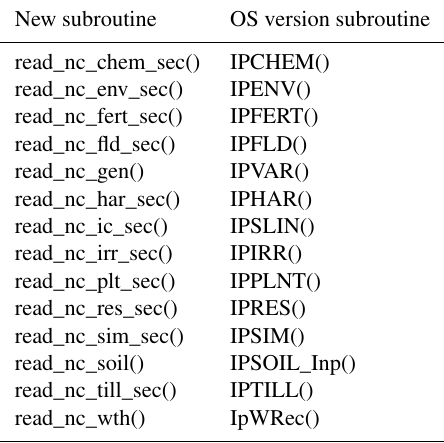
Table 2. New subroutines created in the development of the parallel gridded version (PG) of the Decision Support System for Agrotech- nology Transfer Cropping Systems Model (DSSAT-CSM). New subroutines are listed with the corresponding subroutine from the standard open-source version (OS) of